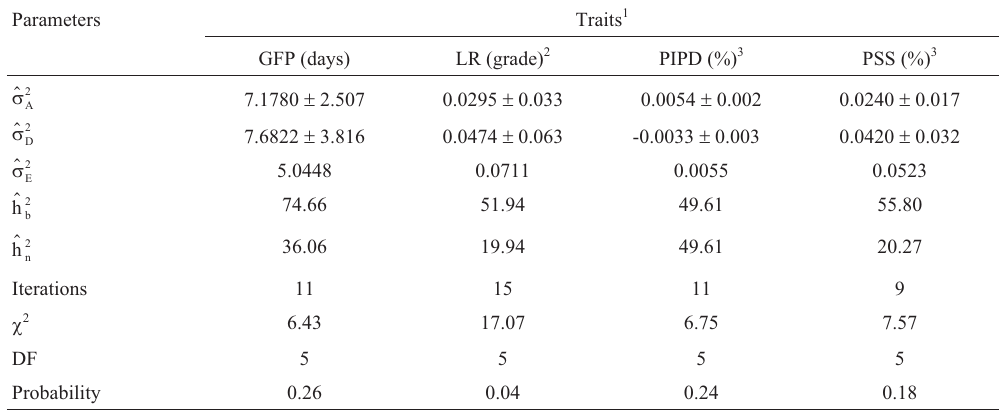
Table 5 - Estimates of additive ( (cid:2) (cid:3) A2 ), dominance ( (cid:2) (cid:3) D2 ) and environmental (cid:2)(cid:3) (cid:2) ) E2 genetic variances, obtained by weighted least squares. Estimates of (cid:2) (cid:2) heritability coefficients in the broad ( h b2 ) and narrow ( h n2 ) senses, and adherence test of the additive-dominant model applied to phenotypic variances of the evaluated